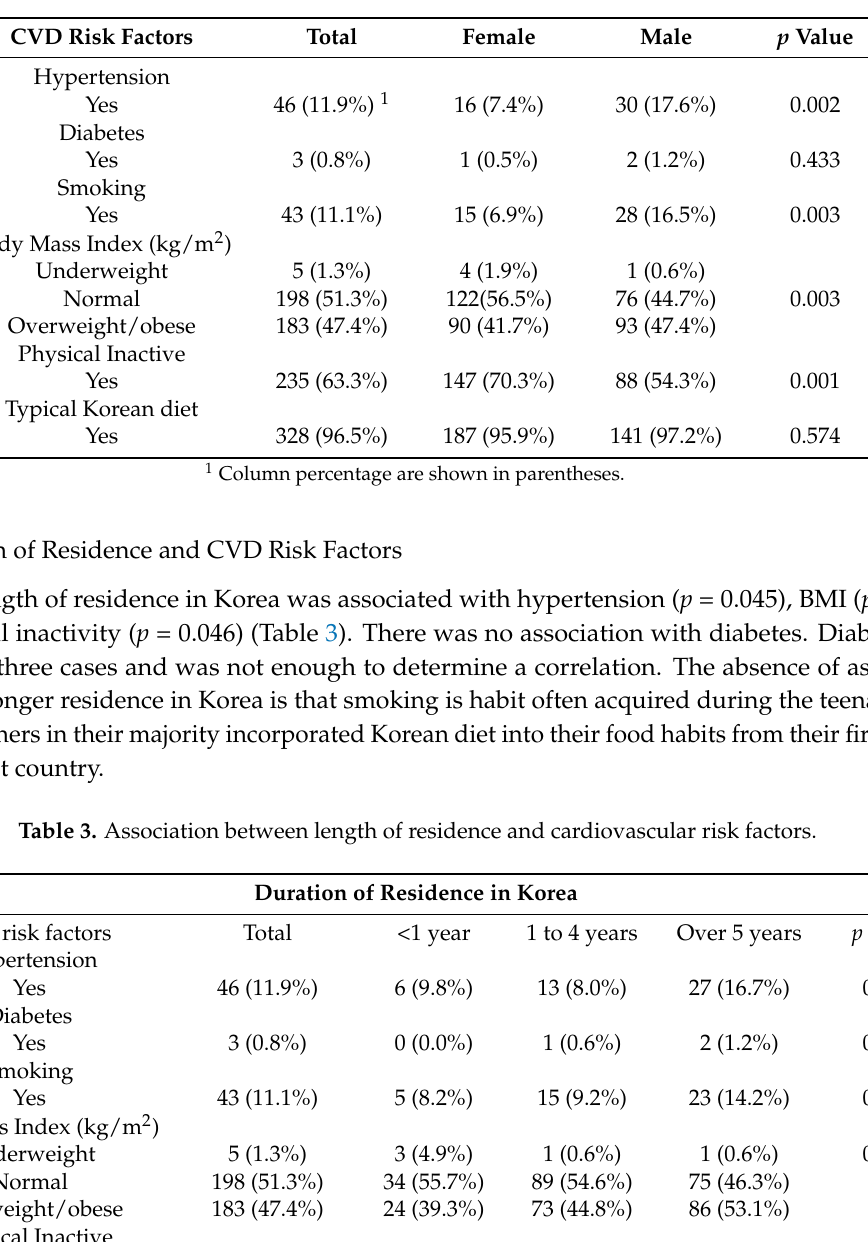
Table 2. Association between gender and cardiovascular risk factors.